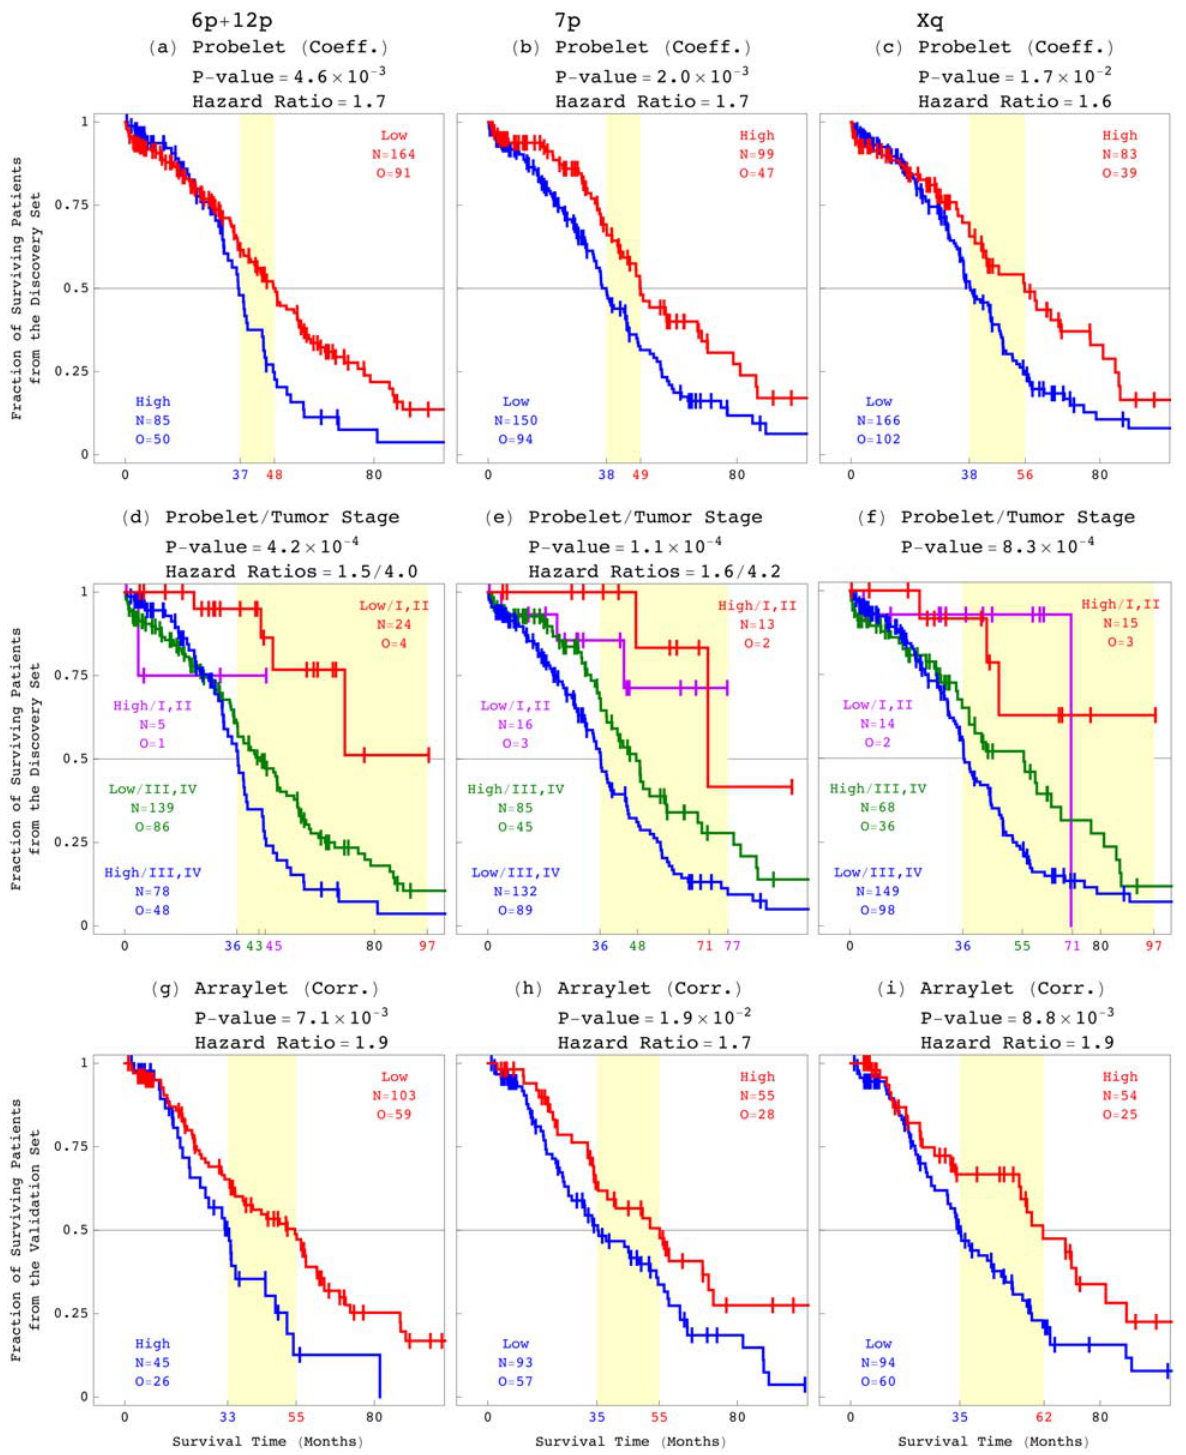
Fig 3. Survival analyses of the discovery and validation sets of patients classified by tensor GSVD, or tensor GSVD and tumor stage at diagnosis. ( a ) Kaplan-Meier (KM) curves of the discovery set of 249 patients classified by the 6p+12p x -probelet coefficient, show a median survival time difference of 11 months, with the corresponding log-rank test P -value < 10 − 2 . The univariate Cox proportional hazard ratio is 1.7. ( b ) Survival analyses of the 249 patients classified by the 7p x -probelet coefficient. ( c ) The 249 patients classified by the Xq x -probelet coefficient. ( d ) The 249 patients classified by both the 6p+12p tensor GSVD and tumor stage at diagnosis, show the bivariate Cox hazard ratios of 1.5 and 4.0, which do not differ significantly from the corresponding